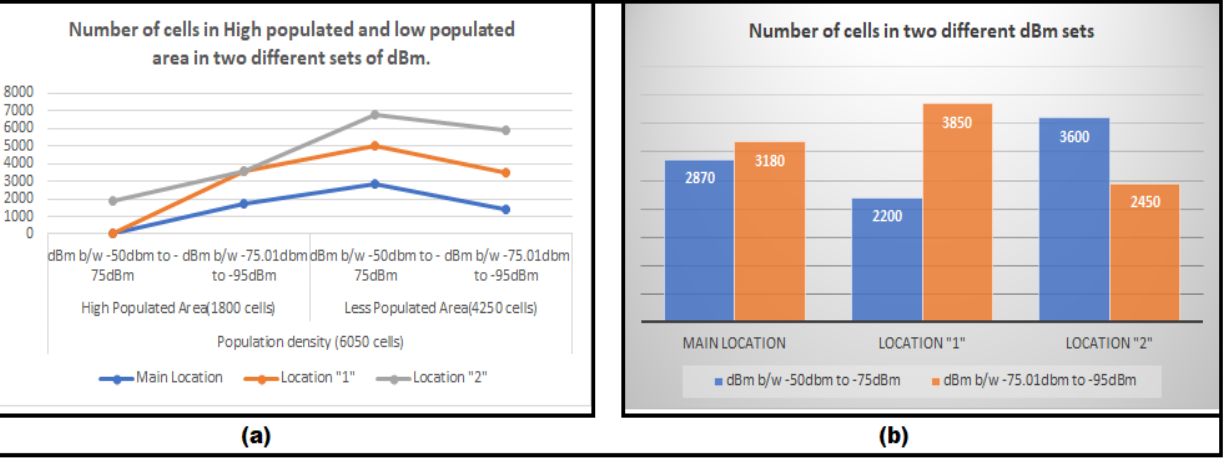
Figure 14. ( a ) Signal strength map for cell tower location “1”. ( b ) Signal strength map for cell tower location “2”.